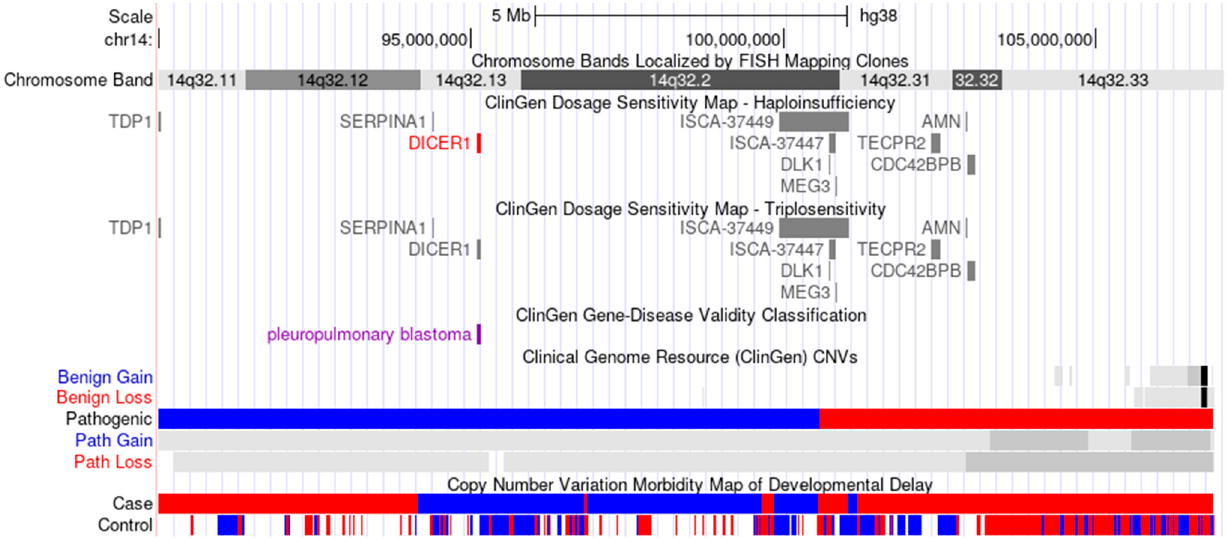
Figure 5. Schematic representation of previously reported cases spanning the terminal 17.2 Mb of chromosome 14q32, including ClinGen Dosage Sensitivity Map and Copy Number variation Morbidity Map of Developmental Delay displayed by UCSC Genome Browser (http://genome.ucsc.edu/; accessed on 30 August 2021). Blue bars indicate pathogenic or related gains based on copy number variation morbidity map of developmental delay.